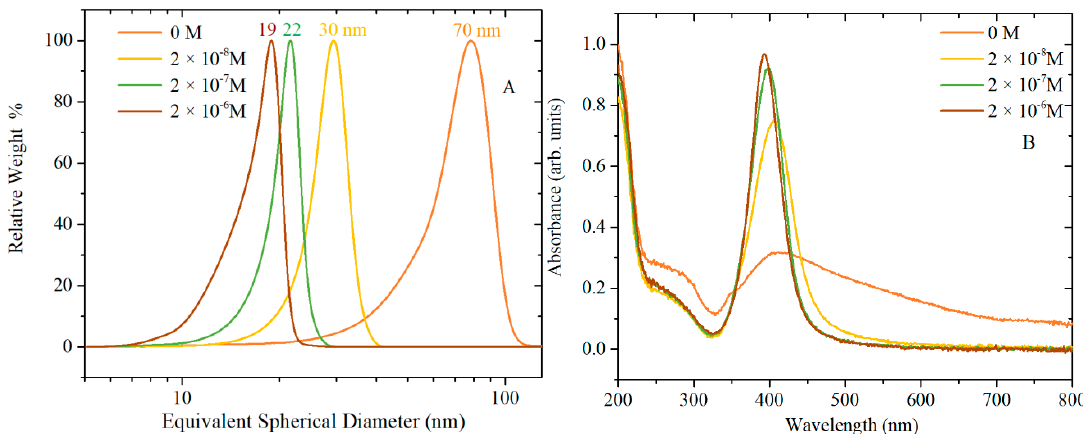
Figure 1. ( A ) Centrifugal Liquid Sedimentation (CLS) results and ( B ) UV-vis spectra of Silver nanoparticles (AgNPs) synthesised at various concentrations of Tannic Acid (TA): 0 M, 2 × 10 − 8 , 2 × 10 − 7 and 2 × 10 − 6 M. CLS and UV-vis spectra show that increasing the TA concentration produces smaller and less polydispersed AgNPs.